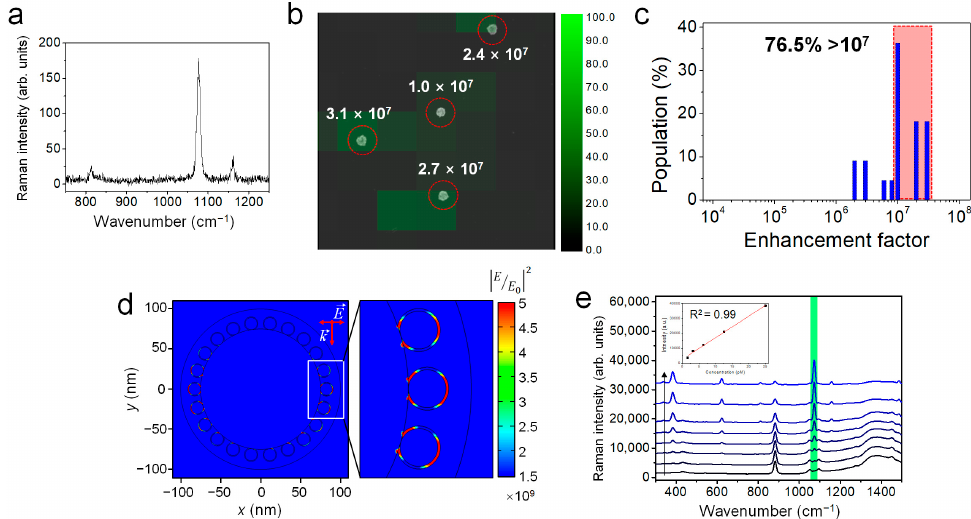
Figure 3. SERS analysis of Ag NGS particles at the single-particle level. ( a ) Typical SERS spectrum obtained from a single Ag NGS particle at an excitation wavelength of 785 nm. ( b ) SERS intensity map with enhancement factor (EF) values at 1075 cm − 1 for 4-FBT. The intensity map was overlaid with the corresponding SEM image. The step size was 1 µ m. ( c ) EF distribution of individual Au NGS particles ( n = 22). The average EF value ( n = 22) was 1.7 × 10 7 , and 76.5% of Ag NGS particles showed EF values over 10 7 . ( d ) Calculated near-field electromagnetic field distributions of Ag NGS using a 785-nm excitation laser. ( e ) Relationship between SERS intensities and Ag NGS concentrations in ethanol, as determined by serial dilution. For each spectrum, the Ag NGS concentration was 0.8, 1.6, 3.1, 6.3, 12.5, 25, 50, or 100 pM (starting from the bottom). The inset shows a linear relationship using Ag NGS samples at concentrations ranging from 1.6 to 25